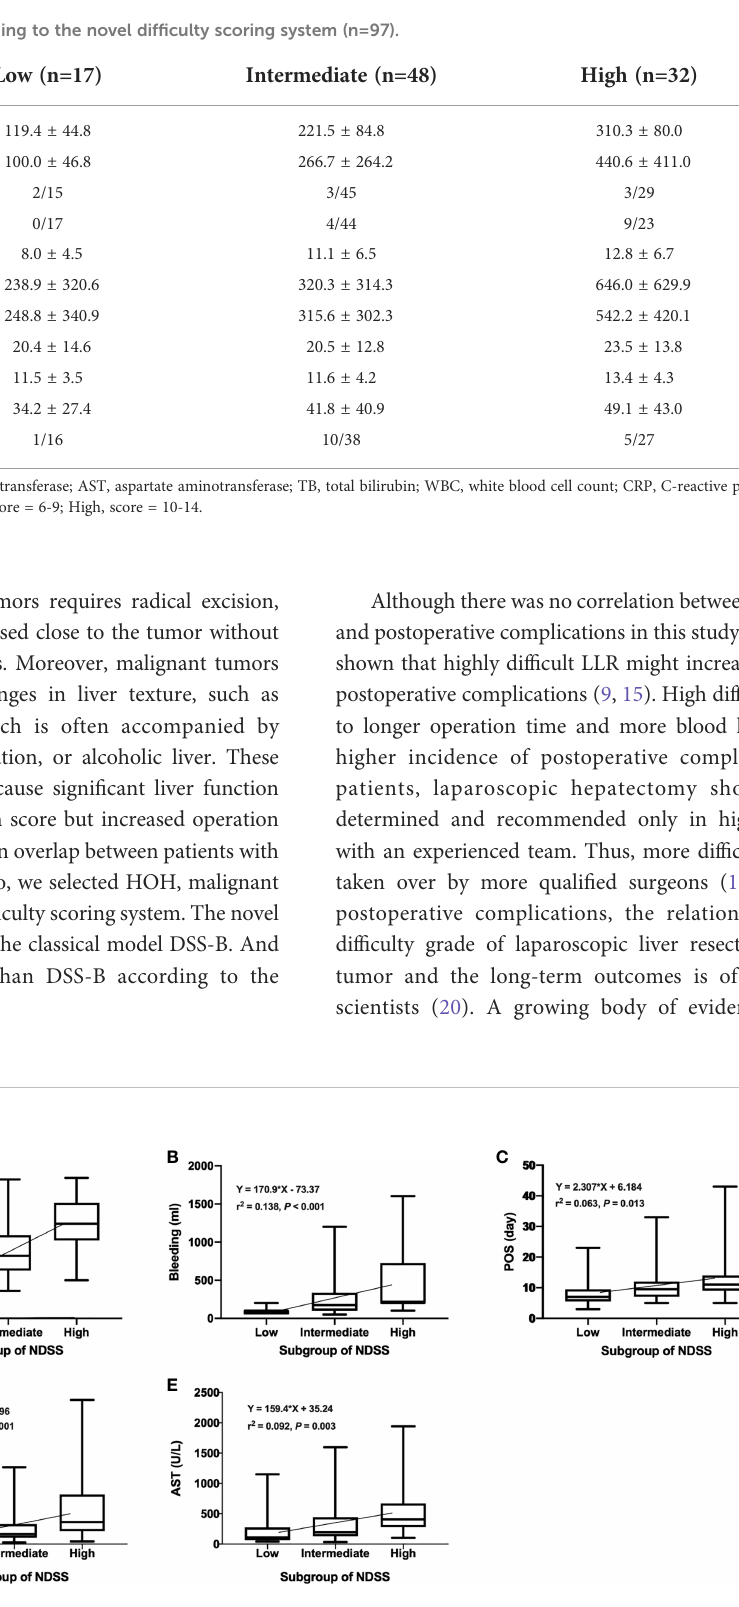
FIGURE 6 Operation time (A) , bleeding (B) , POS (C) , ALT (D) , and AST (E) according to